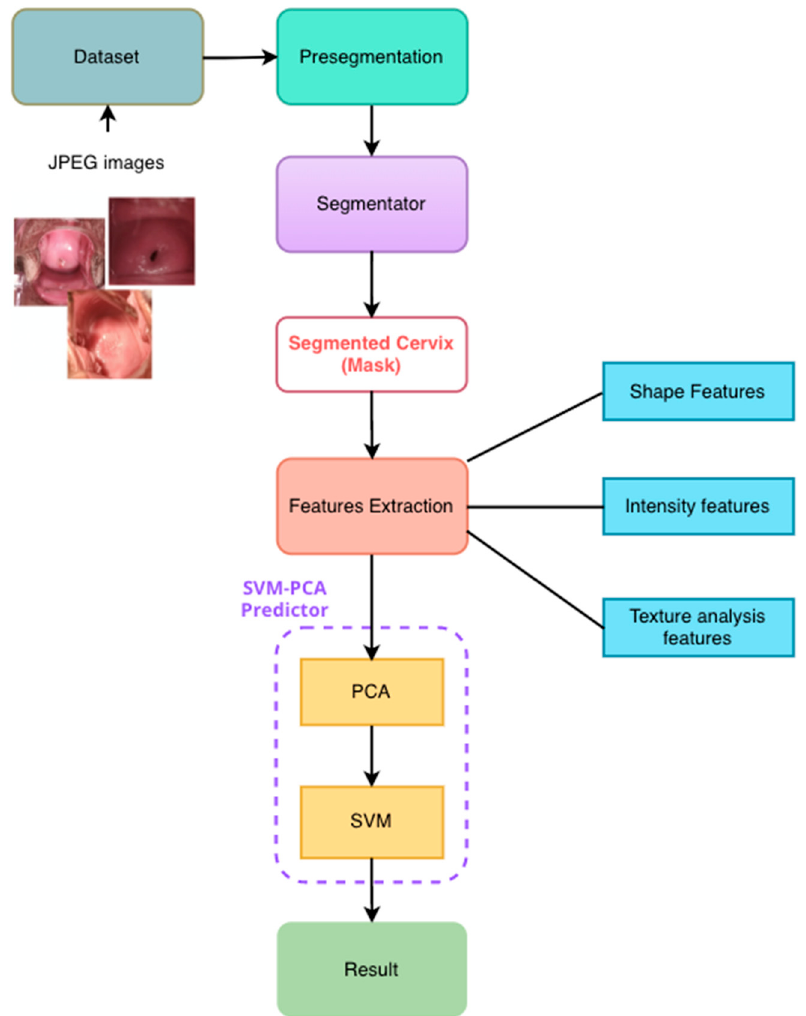
Figure 1. Computer-Aided Diagnostic tool flowchart in cervix images. First, manually cropped re- gions of interest (ROIs) were extracted. Then, synthetic images were generated by data augmentation from the colposcopy RoIs. After that, synthetic and real data were used as inputs for the training of the Unet model and to solve the segmentation problem. Then, some features were extracted from the ROIs, and SVM (Support Vector Machine Learning) was implemented as a classification method. Finally, evaluation metrics were used to evaluate the performance of the